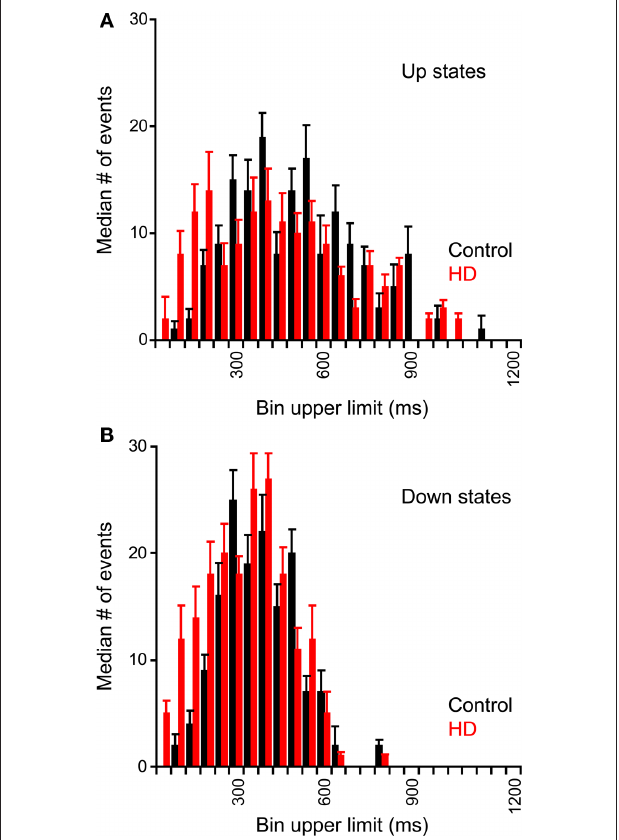
FiguRe 2 | Dwell-time histograms of up and Down state durations of neocortical neurons. Durations of Up and Down states were measured from spontaneous recordings from non-transgenic littermate controls (black) and R6/2 (red) neocortical neurons. Average (median) histograms were constructed of Up States (A) and Down States (B) . Error bars represent between-neuron median absolute deviations. For both Up and Down states, the HD distribution is shifted to the left; however, the differences between control and HD histograms are only significant for the